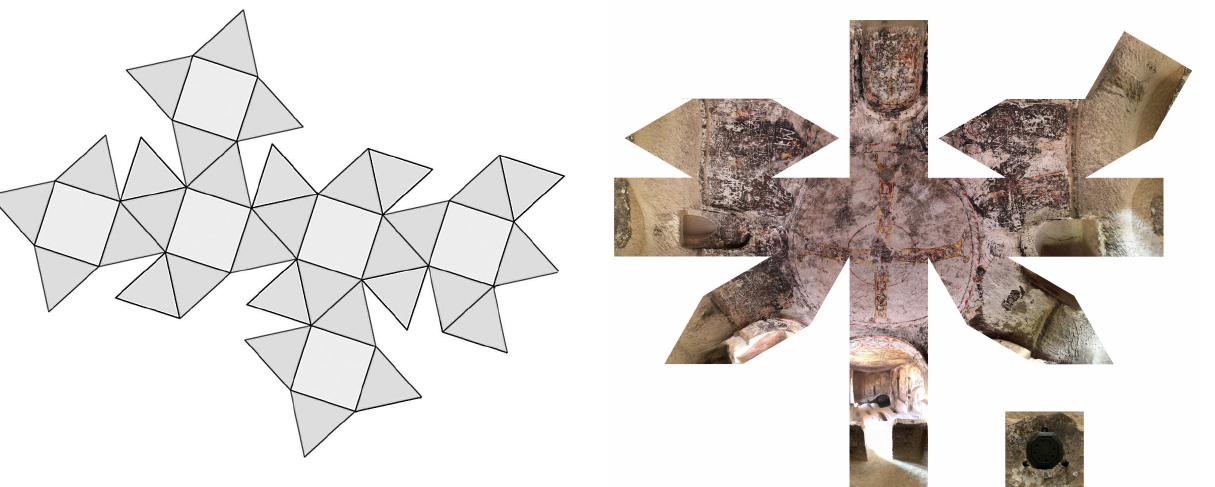
Figure 13. Development of the snub cube.